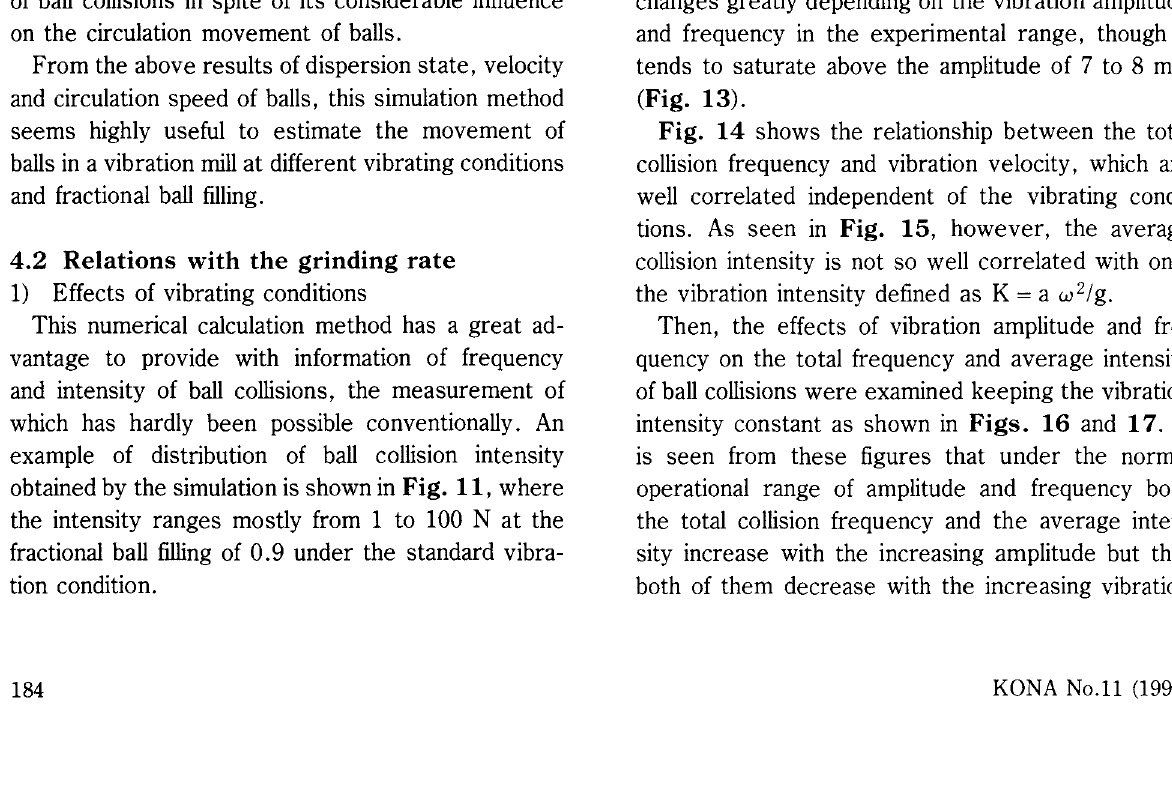
Comparison of circulation of balls obtained by simula tion and observation with VTR at different fractional ball filling